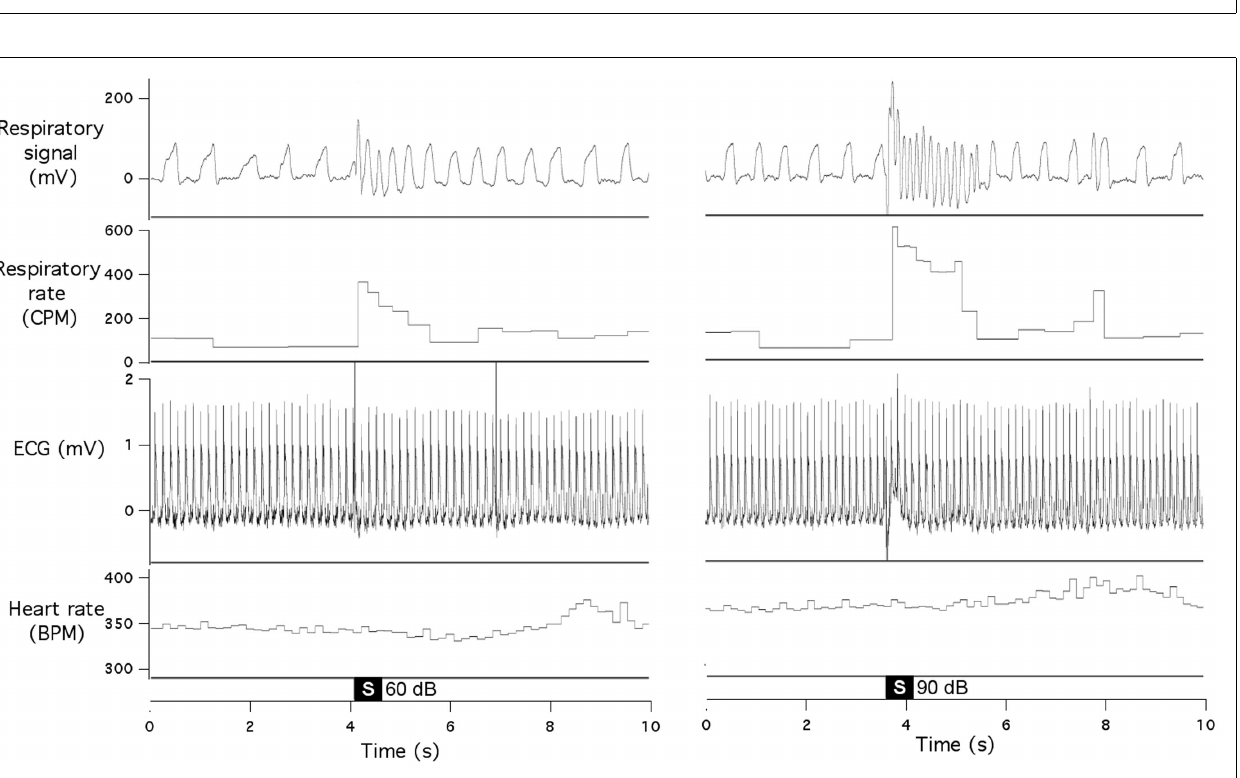
underwent spectral analysis for (B) . Note that no body movement occurred during or after the stimulus (for comparison, effect of a small movement is shown at the end of the bottom trace (asterisk). (B) EEG spectra obtained just before (dotted line) and just after (solid line) presentation of the acoustic stimulus.